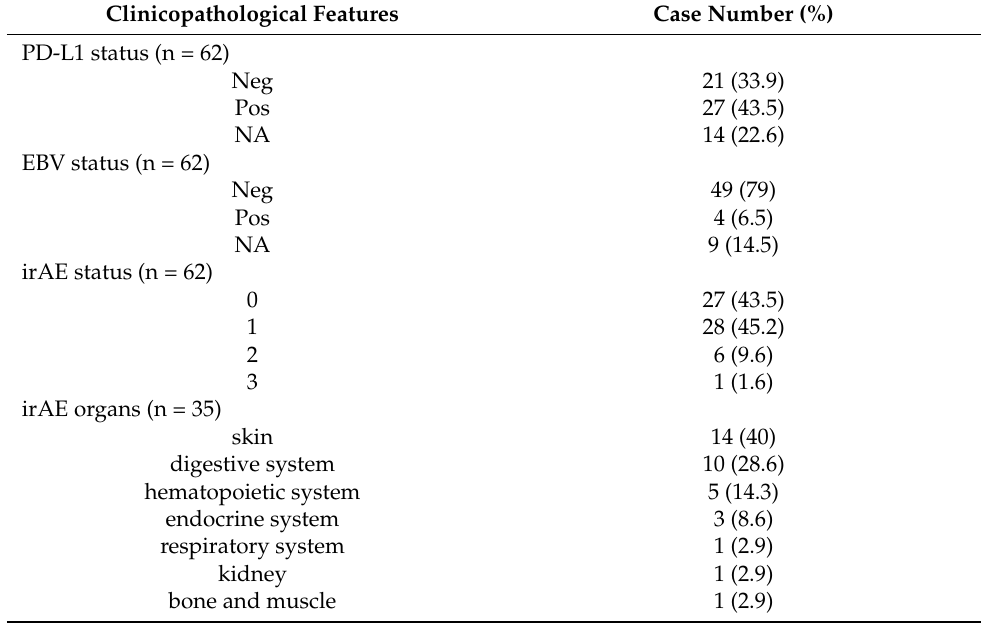
Table 1. Cont . Clinicopathological Features